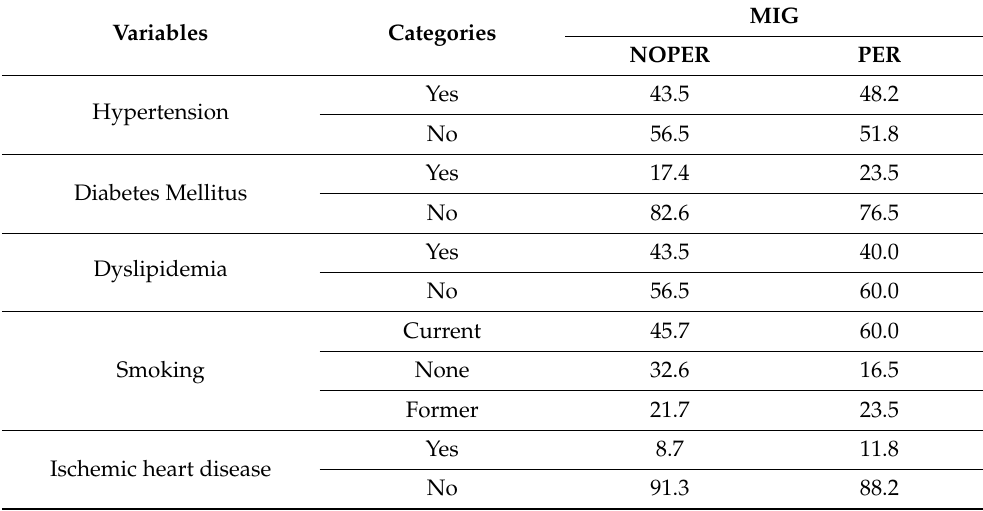
Table 5. Percentages of cardiovascular risk factors in MIG; Chi-square test.